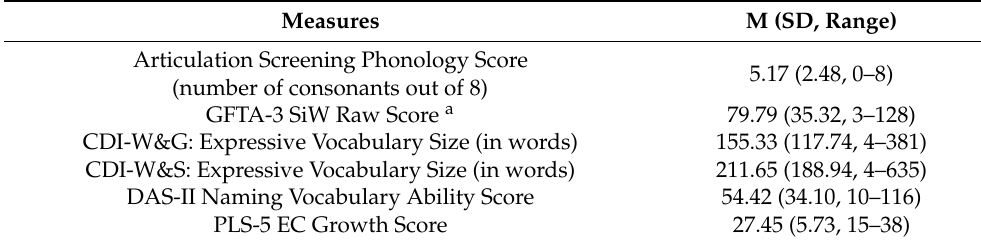
Table 2. Descriptive statistics for the language measures used to define